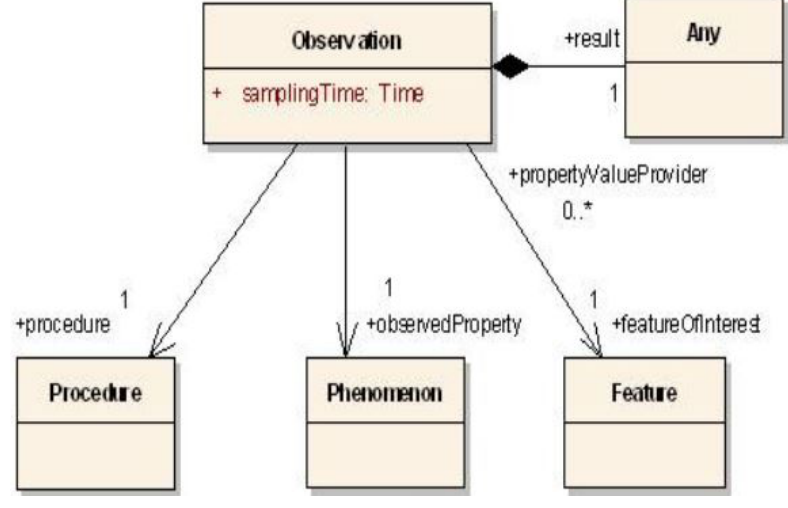
Figure 3. The O&M standard UML